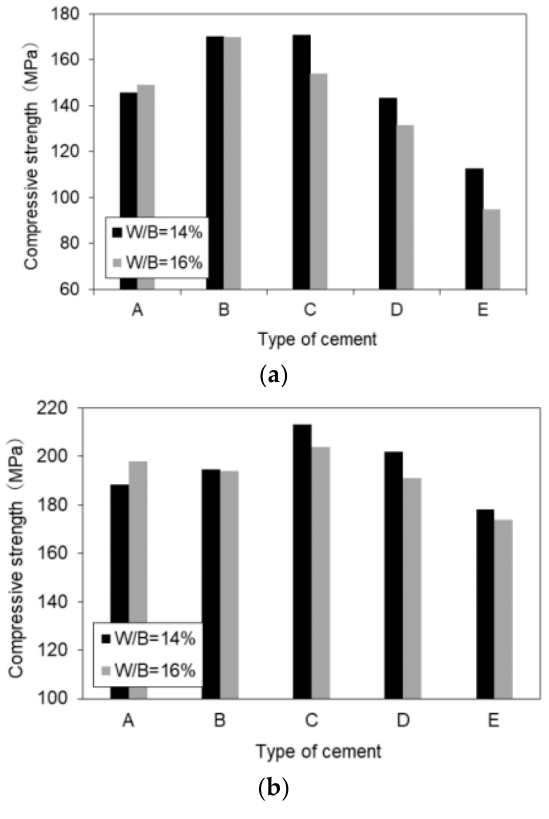
Figure 5. Compressive strength. ( a ) Seven days. ( b ) Twenty-eight days.